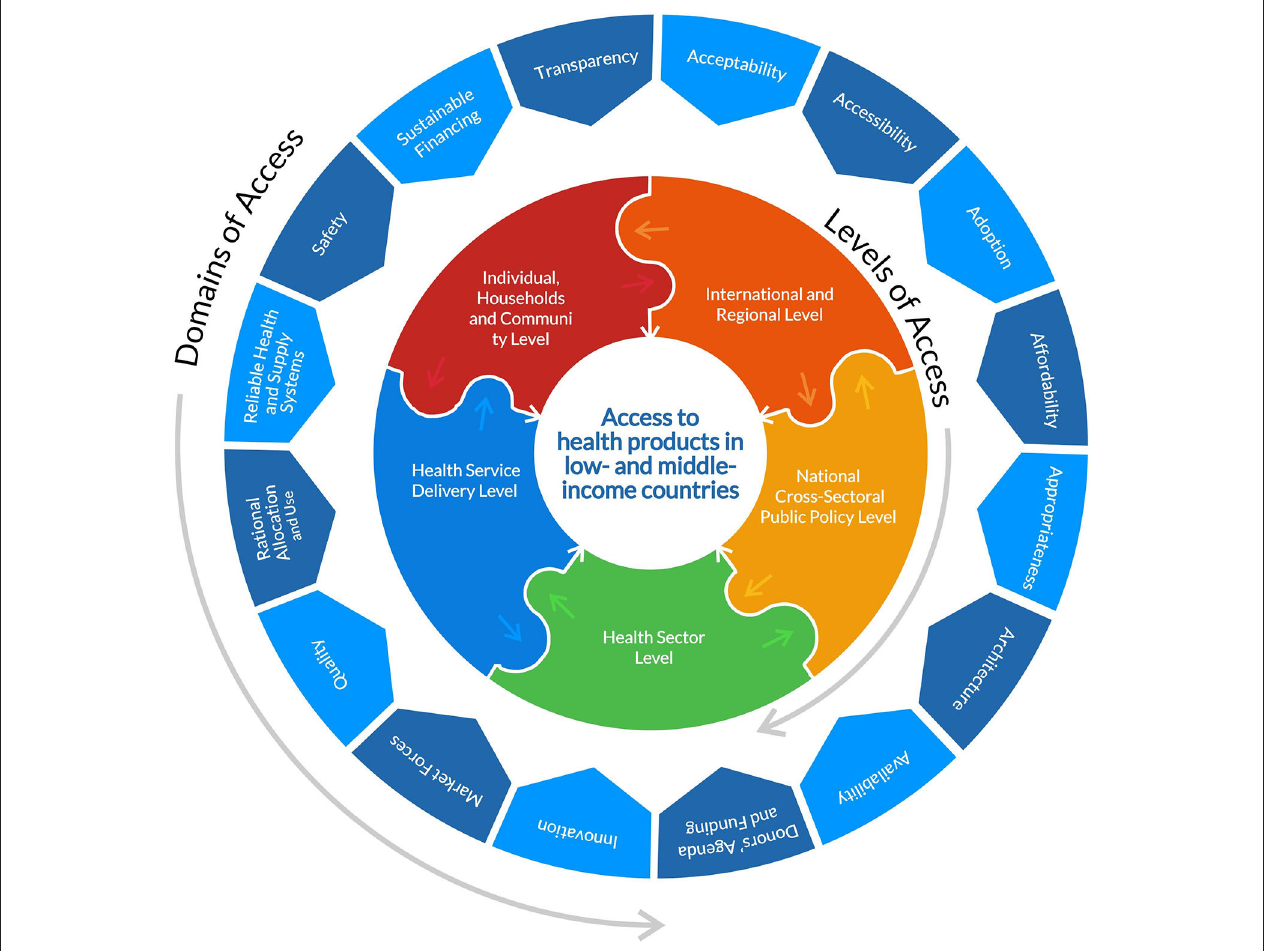
FIGURE 1 | Diagram showing the domains and levels of access adapted from Bigdeli et al. (33) and the JBI model of evidence based healthcare (https://jbi.global/jbi- model-of-EBHC).